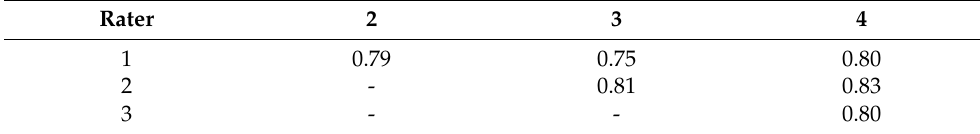
Table 4. Inter-rater